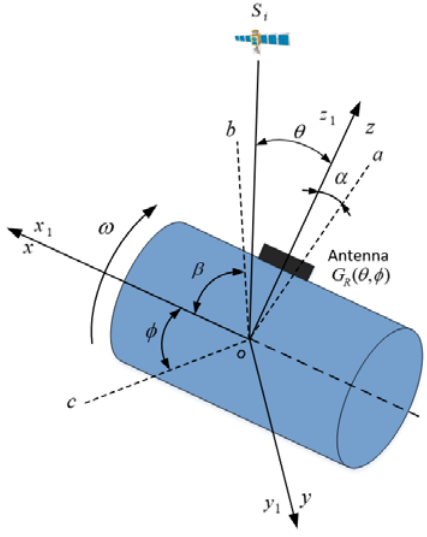
Figure 2. Schematic diagram of the single-patch antenna mounted on a cylindrical vehicle.